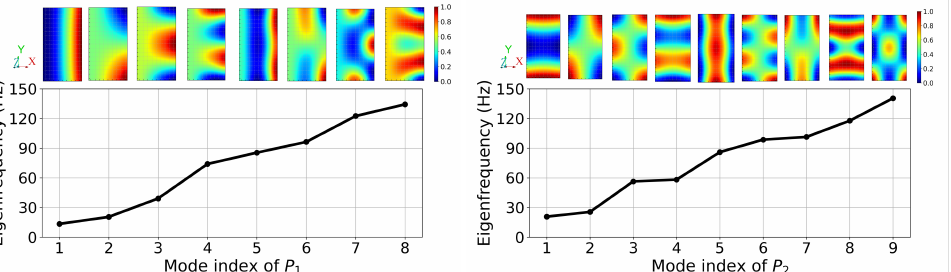
Figure 2. Eigenfrequencies of individual parts of configuration µ P 1 = µ P 2 = 10 − 3 in DOE, with demonstration of mode shapes. ( Left ): first 8 modes for part P 1 . ( Right ): first 9 modes for part P 2 . The amplitude of mode shapes are normalized independently for each mode to the range of [ − 1,